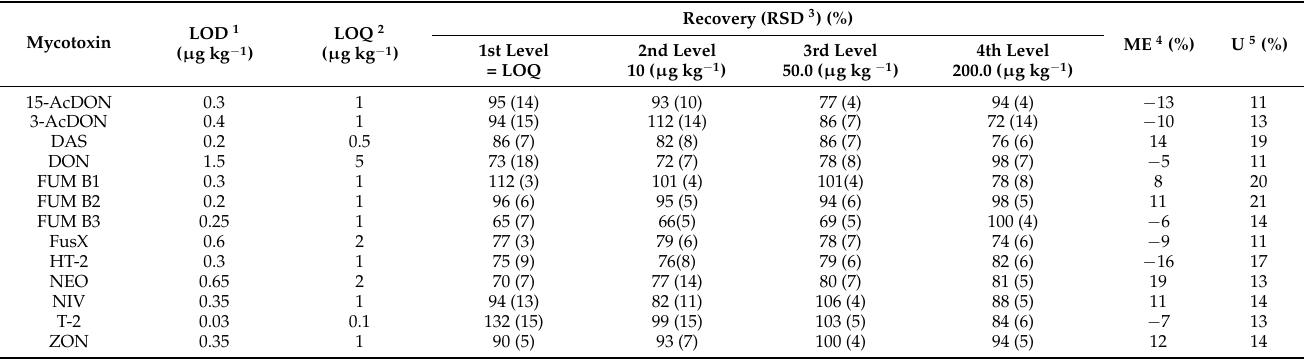
Table A2. Average recoveries, RSDs, LODs, LOQs, and expanded uncertainties U, % (k = 2, confidence level 95%) of mycotoxin in wheat.